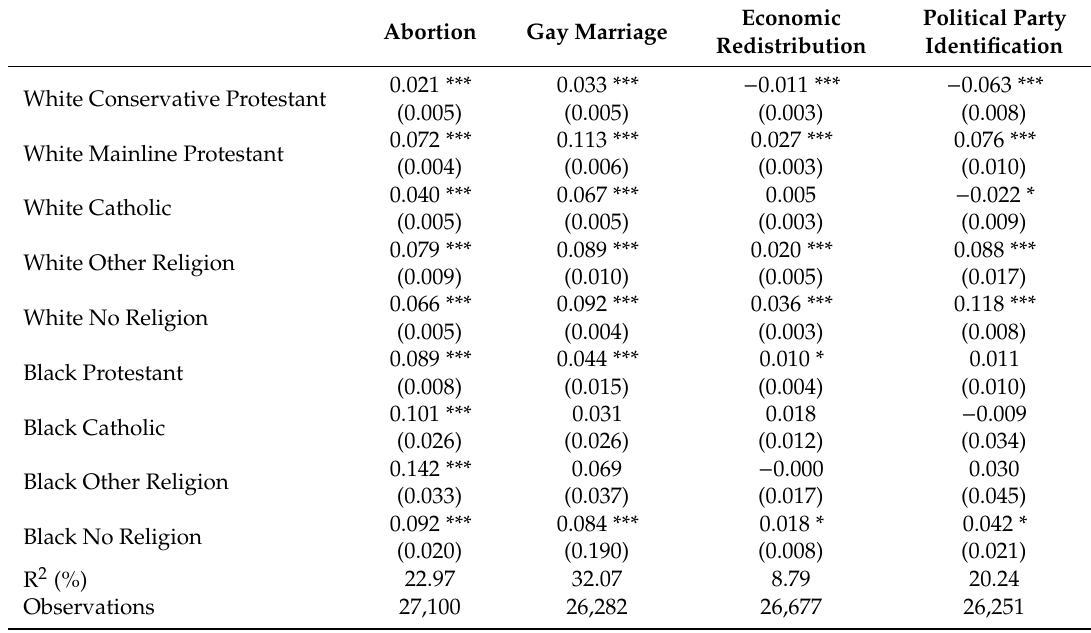
Table 2. Effects of education in ordinary least squares (OLS) models with the interaction of education and nine category religion on political views.